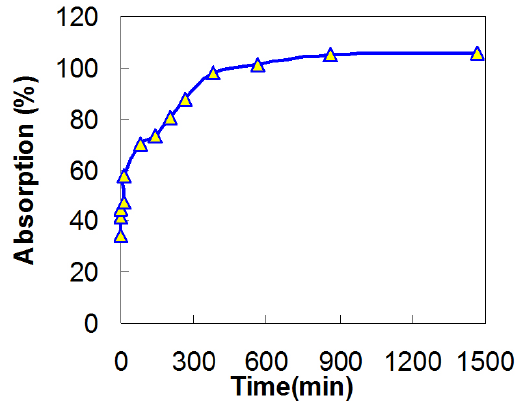
Figure 11. Water absorption rate of